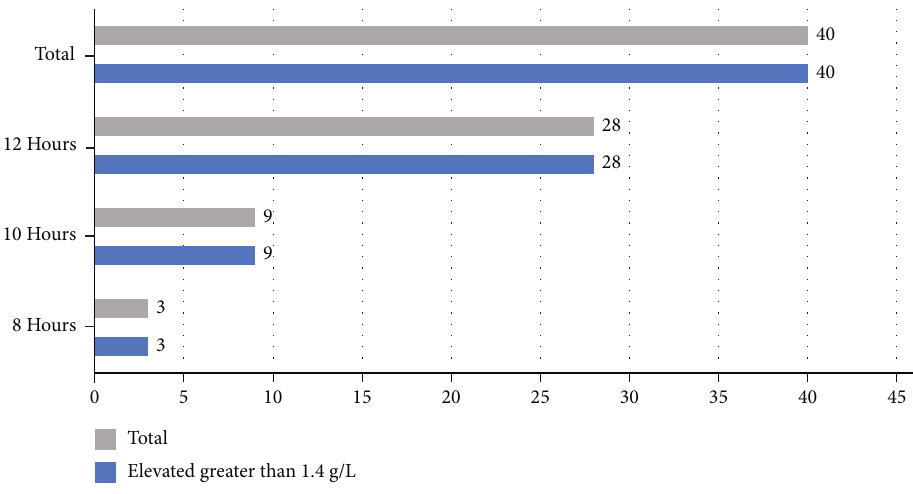
Figure 8: Result of the quanti fi cation of hippuric acid in relation to the working